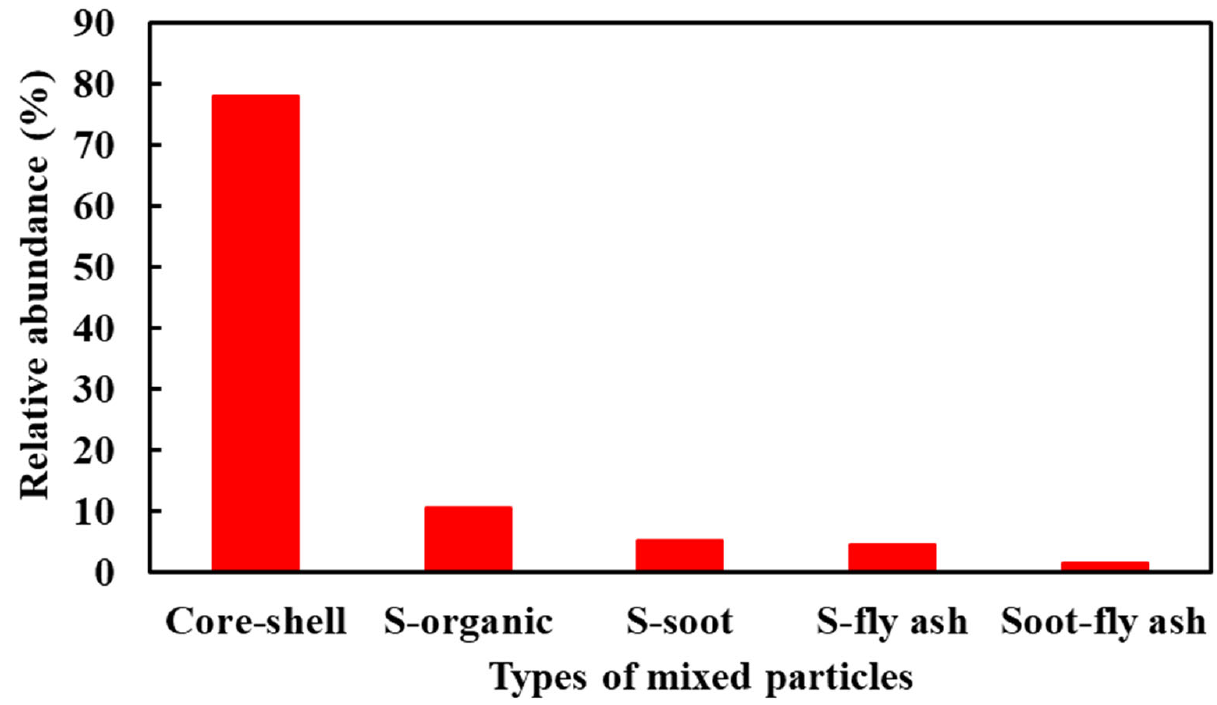
Figure 3. The relative proportions of different types of particles among those identified as mixed particles over all four sampling days in the winter haze of Xi’an during the sampling period. The average sizes of particles in the D1, D2, D3, and D4 samples were 0.54, 0.95, 0.48 and 0.52 µ m, respectively. The relative percentages of different particle types were calculated for different particle size segments (Figure 4). The average sizes of organic particles for the D1, D2, D3, and D4 samples were 0.63, 0.72, 0.48, and 0.47 µ m, respectively. The average sizes of sulfate particles for the D1, D2, D3 and D4 samples were 0.71, 0.88, 0.57 and 0.59 µ m, respectively. The size of organic particles ranged from 0.27 to 1.2 µ m, with a median diameter of 0.44 µ m, and the size of sulfate particles ranged from 0.16 to 1.2 µ m, with a median diameter of 0.75 µ m (Figure 5). The results showed that the mineral particles